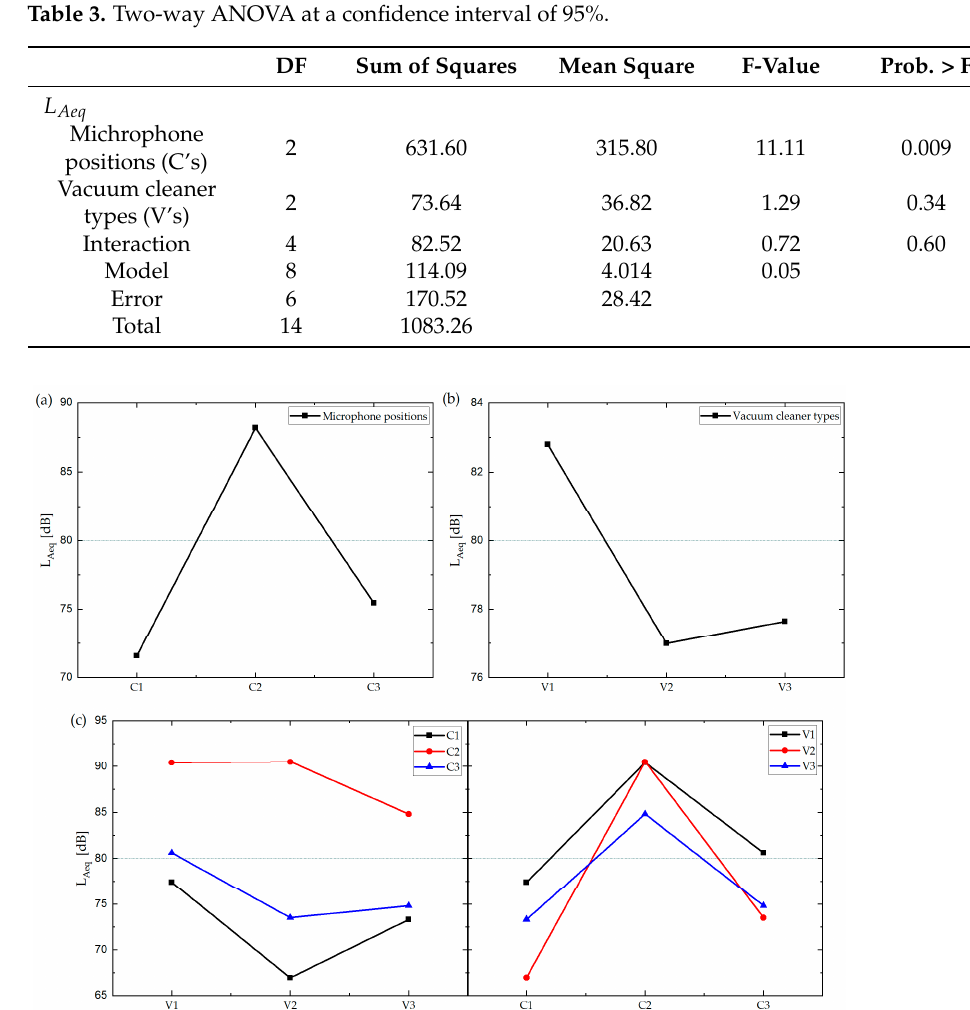
Figure 7. Main effect plots for ( a ) microphone positions versus L Aeq and ( b ) vacuum cleaner types versus L Aeq . ( c ) Interaction plots for equivalent continuous sound